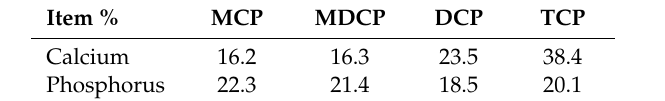
Table 1. Analyzed calcium and phosphorus concentrations in inorganic phosphates (as-is basis). Item % MCP MDCP DCP TCP Calcium